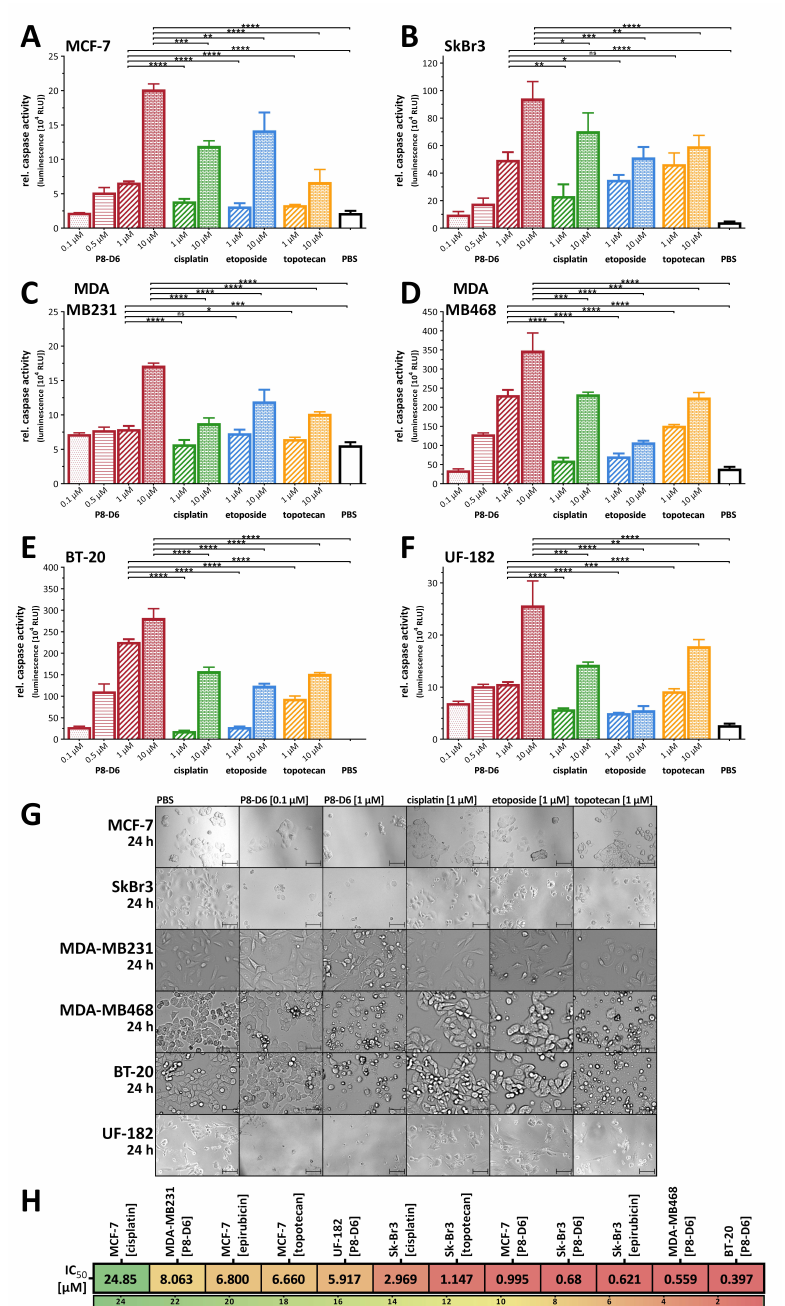
Figure 3. Antitumor responses in BC 2D monolayers. MCF-7, SkBr3, MDA-MB231, MDA-MB468, BT- 20 (cell line) and UF-182 (primary cells) were treated with P8-D6, cisplatin, etoposide, topotecan and PBS as control. The relative caspase activity representing the rate of apoptosis were measured 48 h after treatment in MCF-7 ( A ), SkBr3 ( B ), MDA-MB231 ( C ), MDA-MB468 ( D ), BT-20 ( E ) and UF-182 ( F ) cells. Additionally, the anti-proliferative effects in the cells were visualized by microscopy after 24 h treatment. Scale bars, 50 µ m ( G ). Heat map presents the IC50 values calculated by viability ( H ). P8-D6 was compared to cisplatin, epirubicin and topotecan. Data are means + SD one-way ANOVA, * ( p < 0.05), ** ( p < 0.01), *** ( p < 0.001), **** ( p < 0.0001), ns